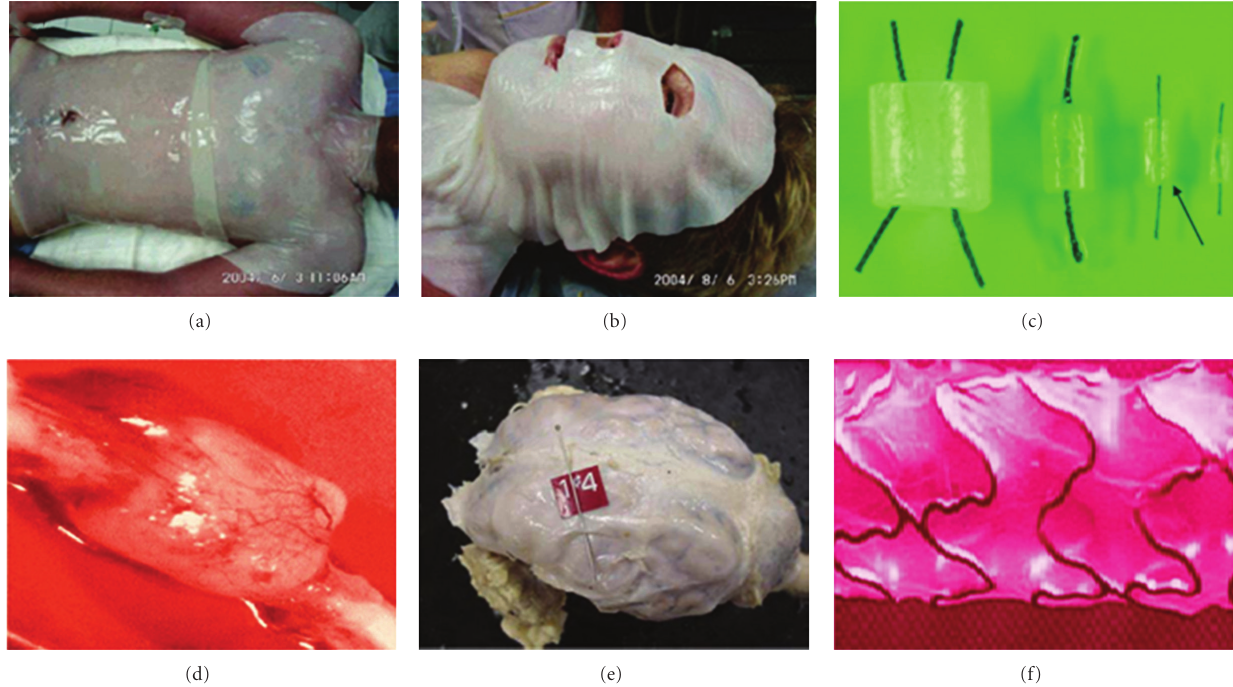
Figure 21: Biomedical applications of nanocellulose (a) and (b) never dried nanocellulose membrane [203]; (c) and (d) artificial blood vessels [205]; (e) dura mater reconstruction [202] (f) covering Stents